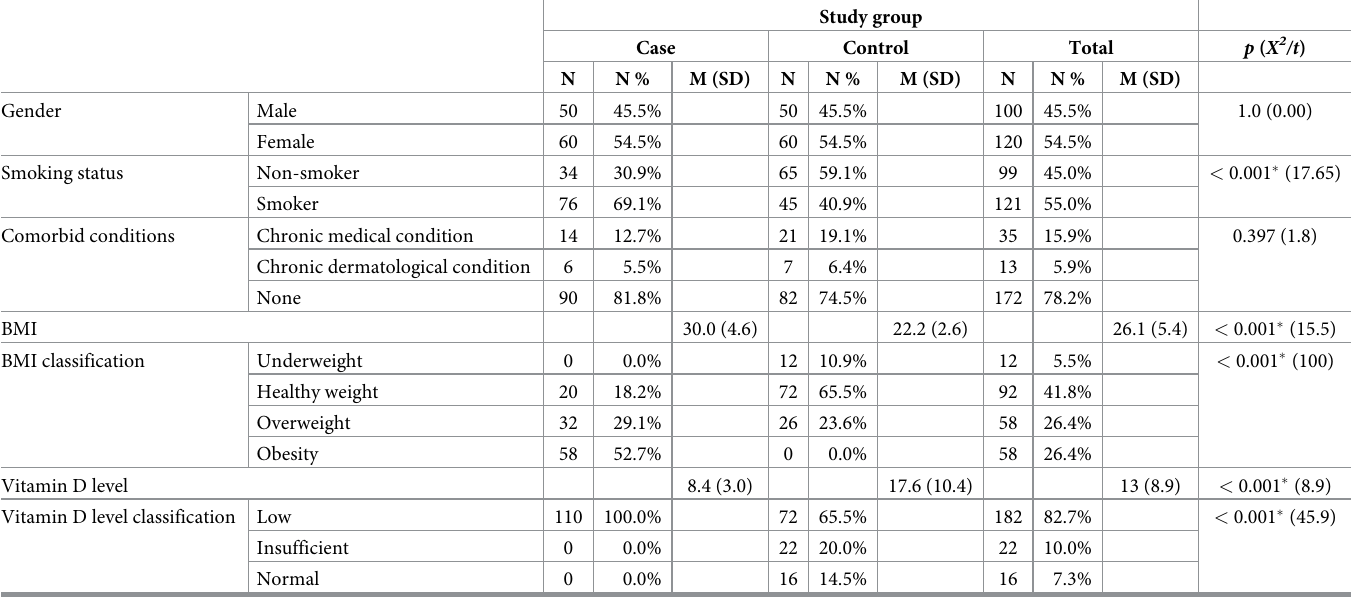
Table 1. Demographic and clinical data of study